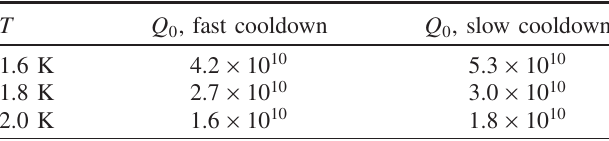
TABLE II. Quality factors at different temperatures measured after fast and slow cooldown on a dressed ERL cavity.